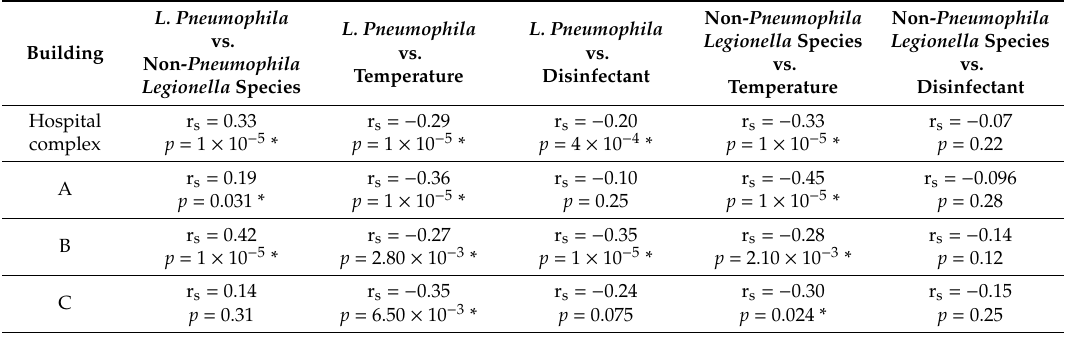
Table 6. Matrix correlation between L. pneumophila , non- pneumophila Legionella species, temperature, and disinfectant (Spearman’s rho